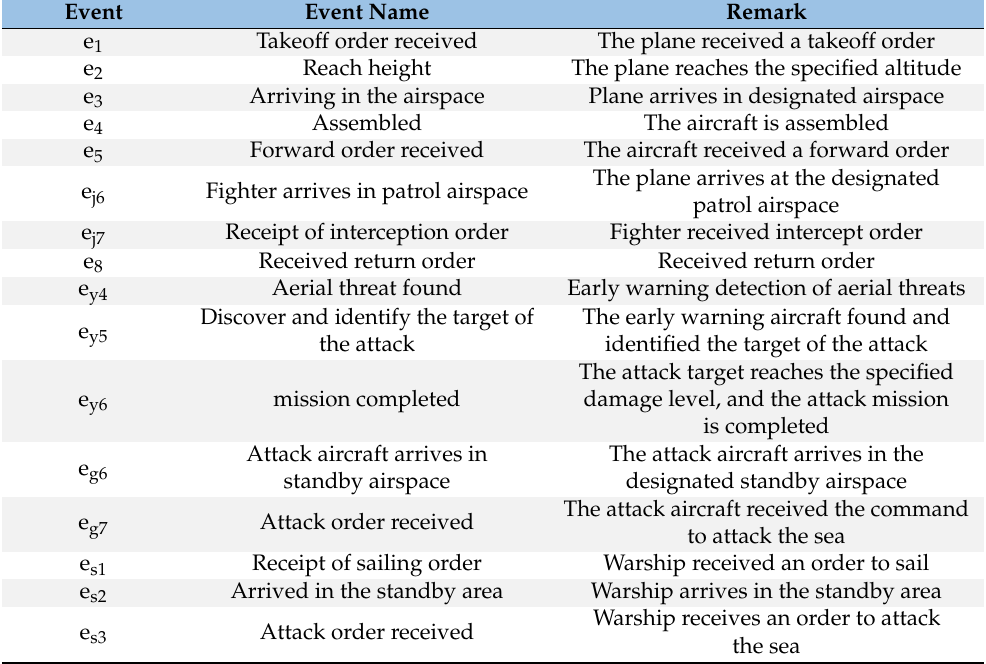
Table 2. List of air and sea jointed anti-sea assaults in naval battlefield.